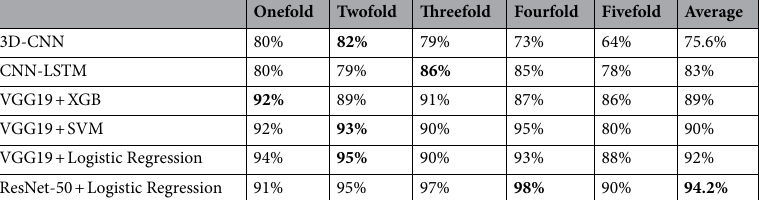
Onefold Twofold Threefold Fourfold Fivefold